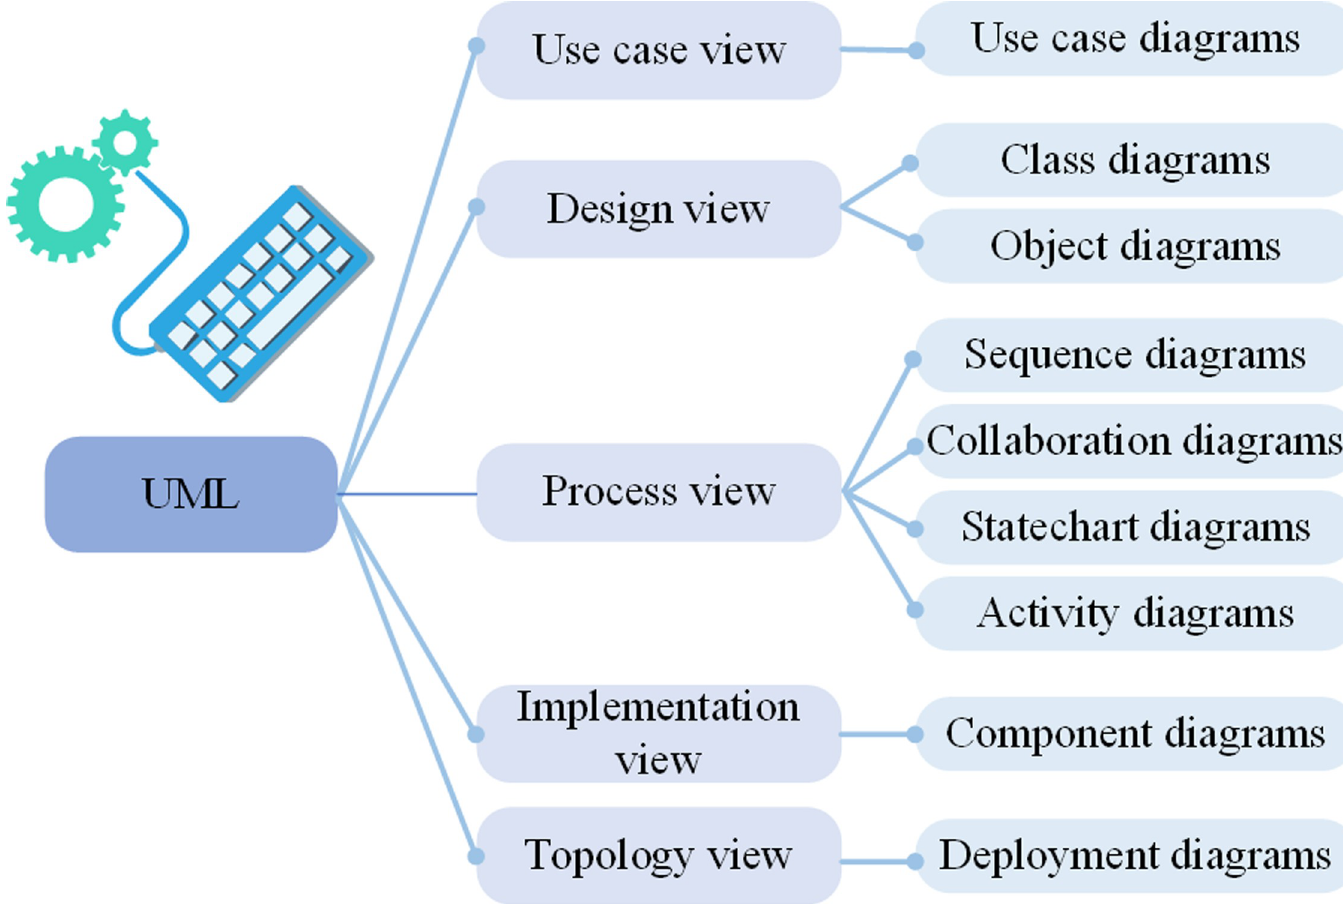
Fig 7. Basic classification of UML